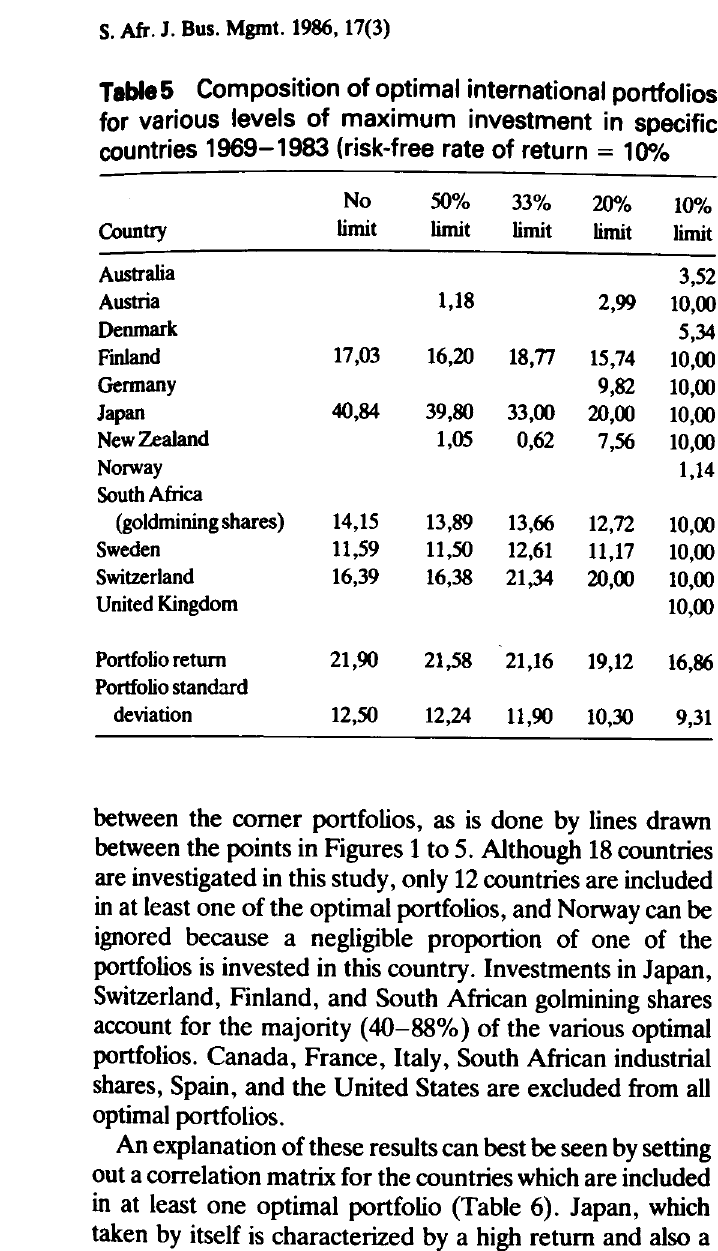
Table& Inter-country correlation coefficients for countries included in optimal investment portfolios